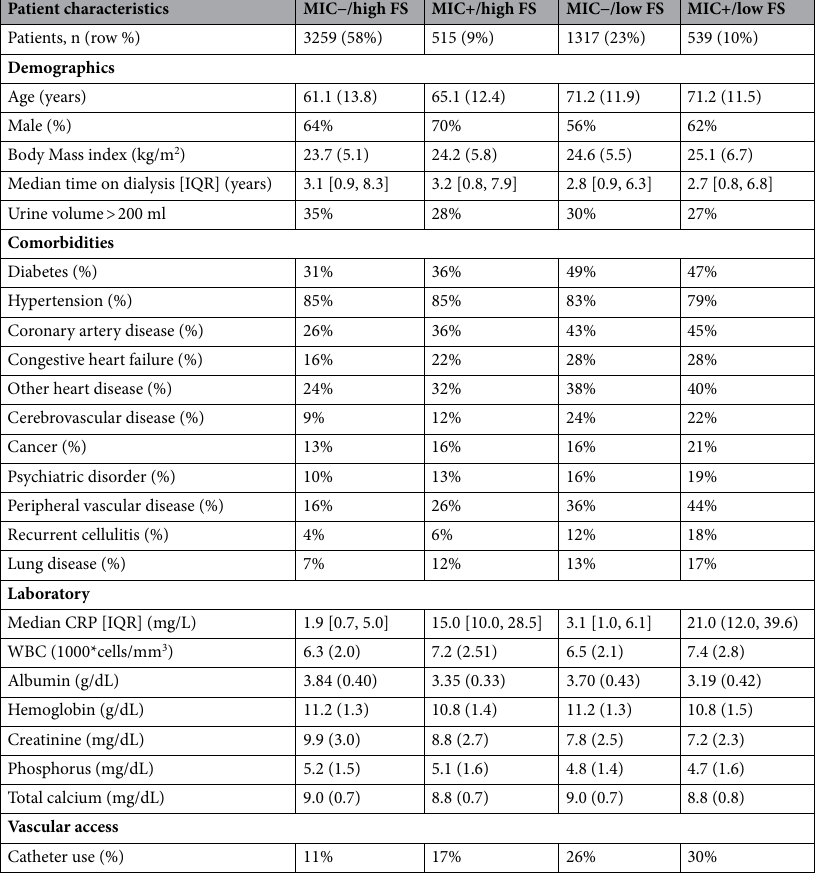
Table 3. Patient characteristics according to combined MIC/FS categories. Values are shown as average (standard deviation). MIC, malnutrition-inflammation-complex; FS, functional status; BMI, body mass index; GI, gastrointestinal; CRP, C-reactive protein; IQR, interquartile range; WBC, white blood cell count.